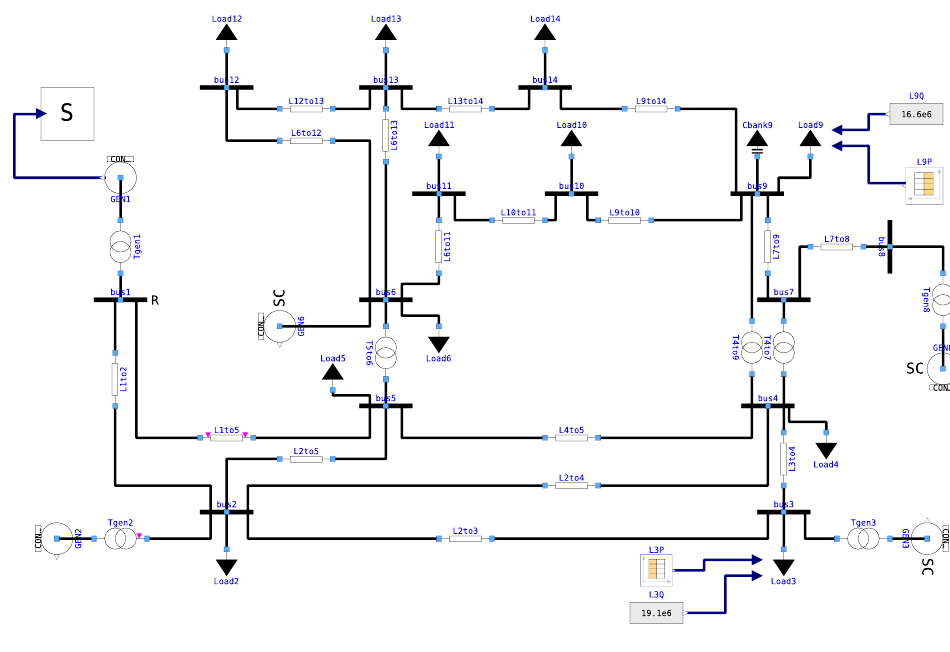
Figure 9. IEEE 14-bus system implemented using PowerGrids in OpenModelica.